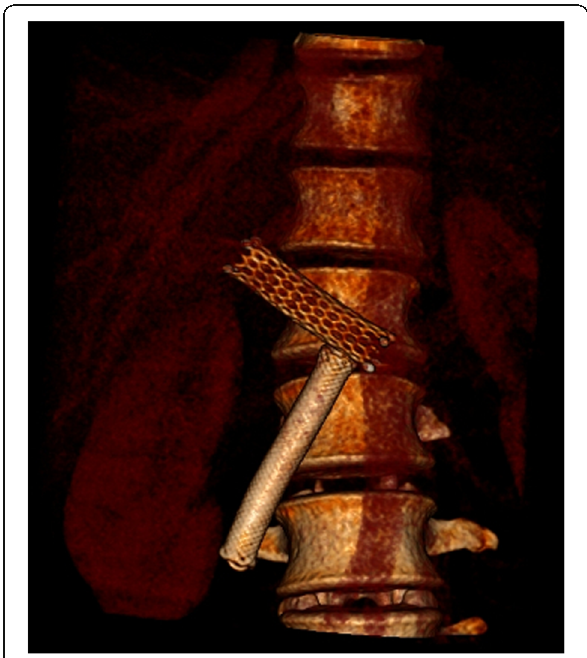
Fig. 5 3d CT reconstruction of the covered vascular stent and the biliary stent. 3d reconstruction of a follow-up CT of the abdomen showing the relationship of the portal vein stent and the common bile duct stent. The covered portal vein stent has successfully excluded the